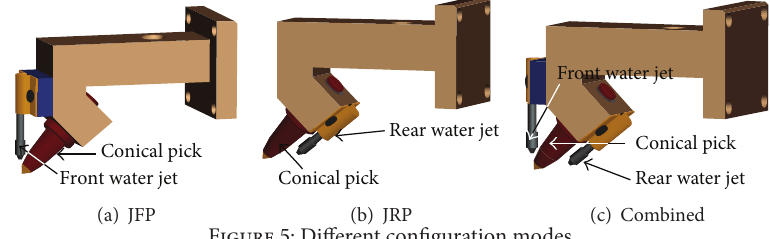
Figure 5: Different configuration modes.